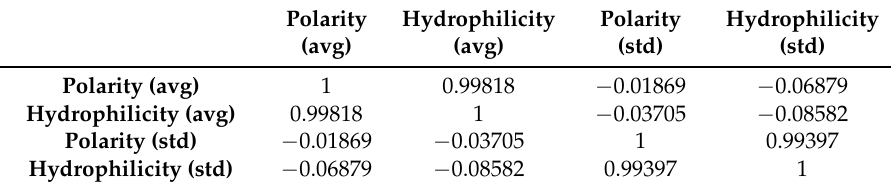
Table 4. Pearson correlation coefficients between polarity and hydrophilicity.